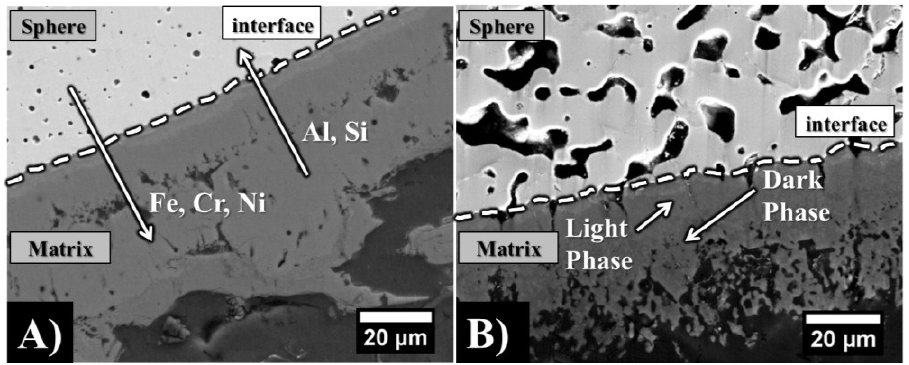
Figure 7. Backscattered SEM images of the microstructure at the sphere-matrix interface showing the intermetallic layer for Al-S CMF samples made with ( A ) 3.7 mm and ( B ) 4.0 mm sphere.